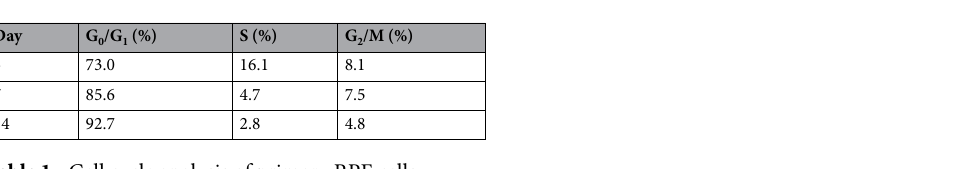
lots of primary RPE cells as a negative control (1 ± 0.35 [fold over the average of five lots ± standard deviation]), the LLOD of the TNNT1 qRT-PCR assay was calculated as 2.1 (Fig. 4a). These results indicated that the TNNT1 qRT-PCR assay is able to detect 3% of ARPE-19 cells contained in primary RPE cells. Next, RNA isolated from undifferentiated hiPSCs, hiPSCs after 5 and 40 days of differentiation, and purified hiPSC-derived RPE cells was subjected to the TNNT1 qRT-PCR assay. The mRNA expression of TNNT1 gradually decreased during differen- tiation to a final level below the LLOD. Relative values of TNNT1 mRNA of the hiPSC, day 5, day 40, and purified hiPSC-derived RPE samples were 123.8 ± 18.0, 62.8 ± 6.0, 17.7 ± 2.2, and 1.2 ± 0.1, respectively (Fig. 4b). These